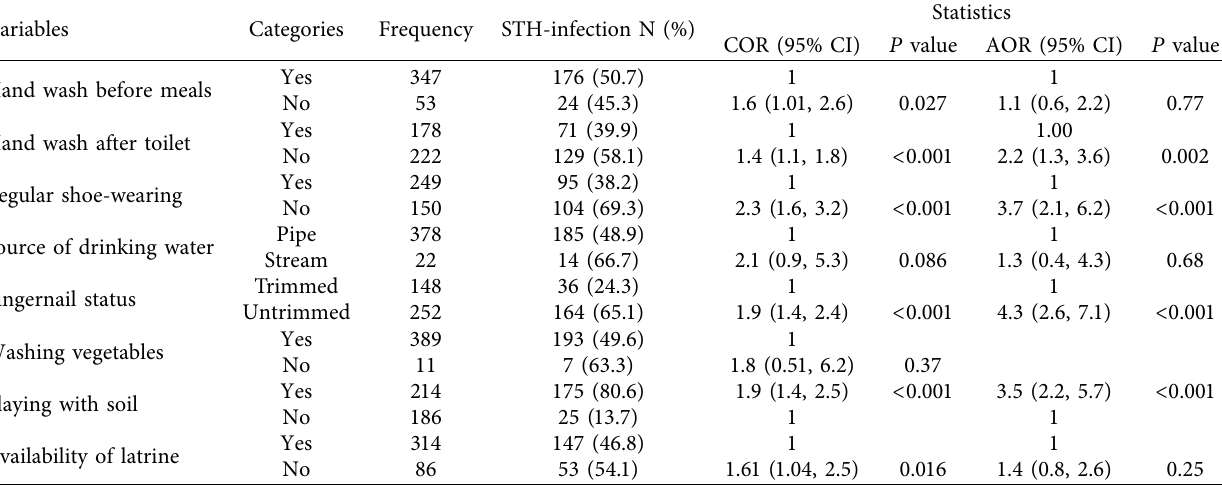
Table 3: Bivariable and multivariable analysis of factors associated with STH infection among Kola Diba primary school children ( n � 400), Northwest Ethiopia.